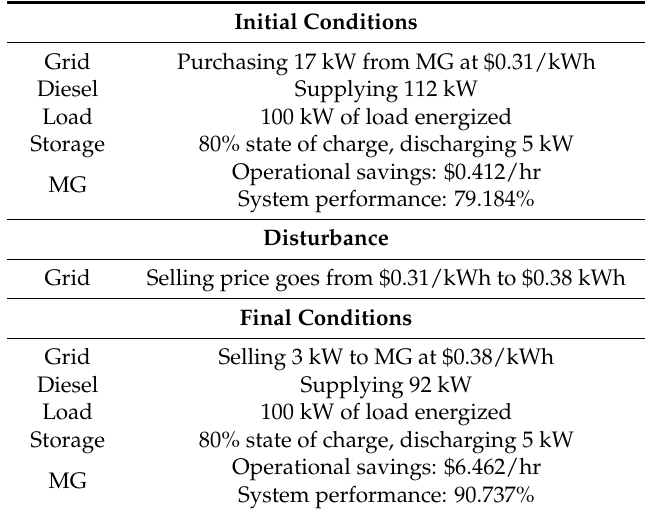
Table 4. Scenario Parameters.